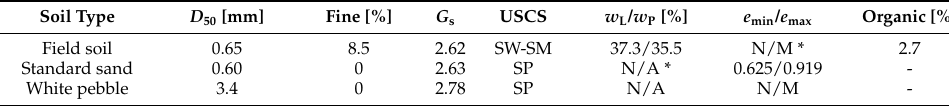
Figure 1. Particle size distribution of used soils and their photographs. Table 1. Engineering properties of used